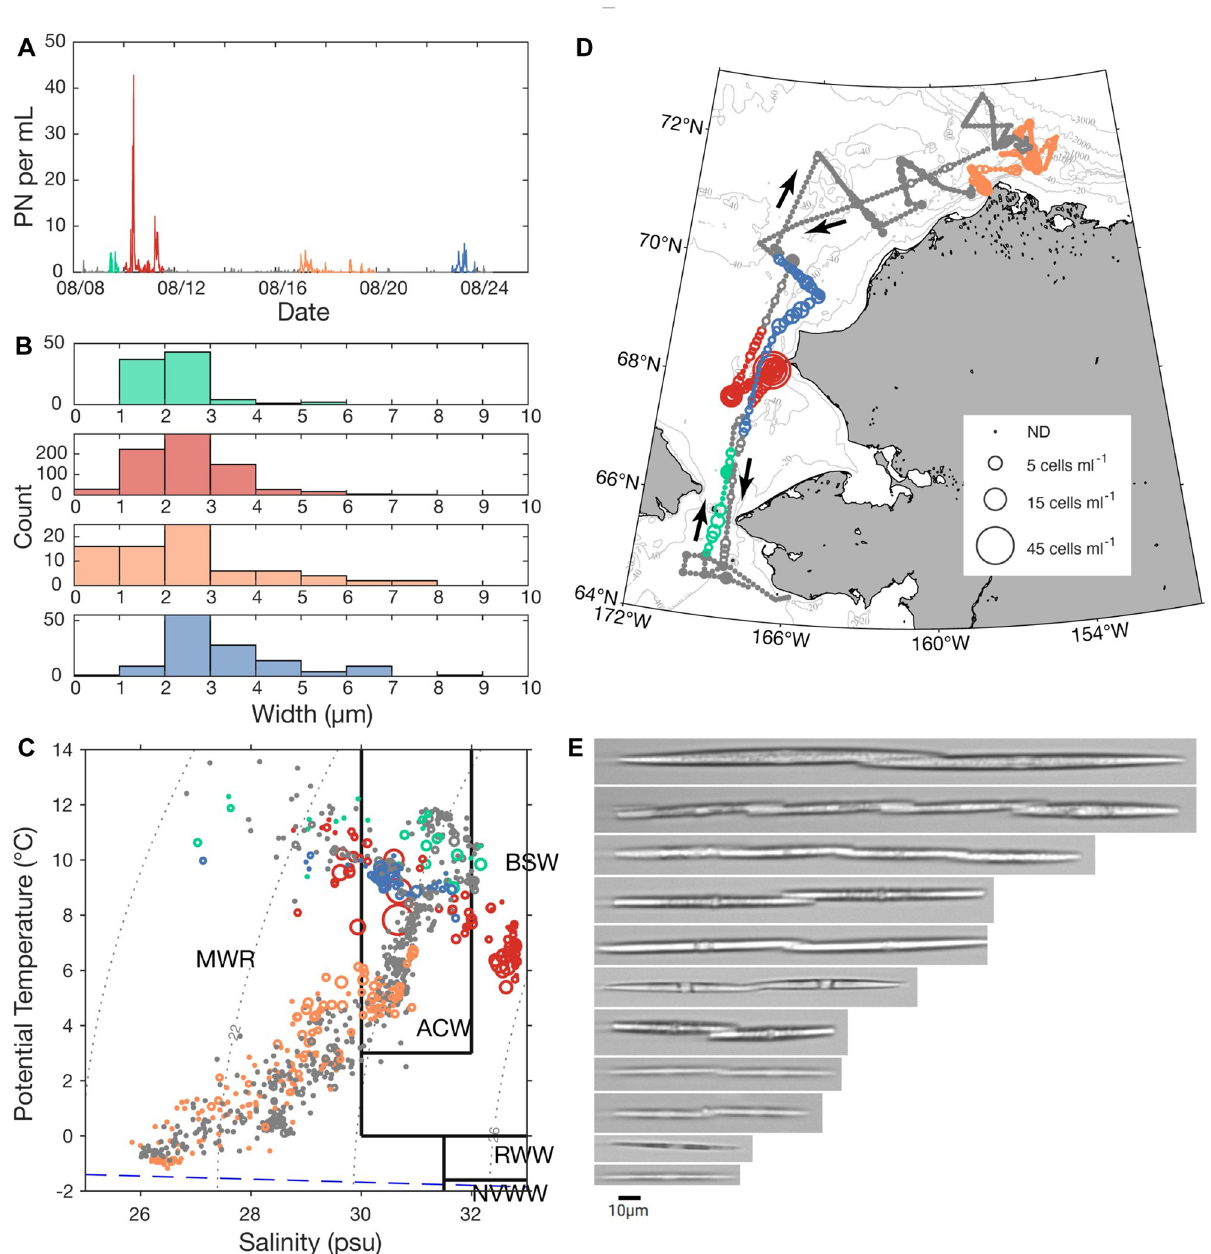
Fig 6. Underway IFCB sampling results for summer ( Healy 1801). Four patches (differentiated by color) of highest observed Pseudo-nitzschia cell abundance are shown: A) Pseudo-nitzschia cells mL -1 over time; B) size-class distribution of cells based on width in each patch; C) Pseudo-nitzschia cellular abundance overlaid on concurrently recorded temperature and salinity measurements; potential density (dotted gray curves), boundaries defining water masses (solid lines) and the freezing point of seawater (blue dashed line) are indicated; D) cellular abundance plotted along the cruise track; arrows indicate direction of travel and asterisk denotes DBO4 transect; E) Examples of cells and chains classified as Pseudo-nitzschia .